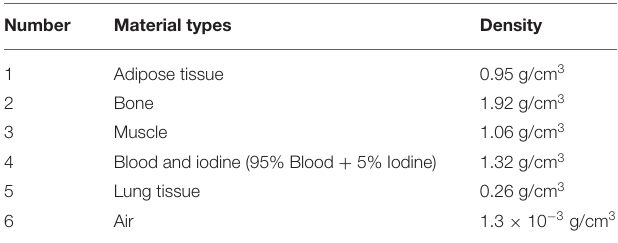
TABLE 1 | Material types and